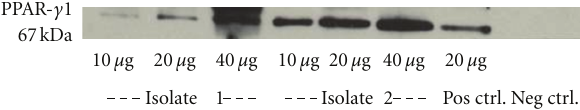
Figure 1: Western Blot analysis of PPAR γ -1 in two di ff erent isolates o unstimulated mesothelial cells. Total protein was extracted from unstimulated peritoneal mesothelial cells or human breast carcinoma cells (positive control) and were analysed using the Western Blot technique. The amount of total protein loaded is indicated. Pos. ctrl: positive control; neg. ctrl: negative